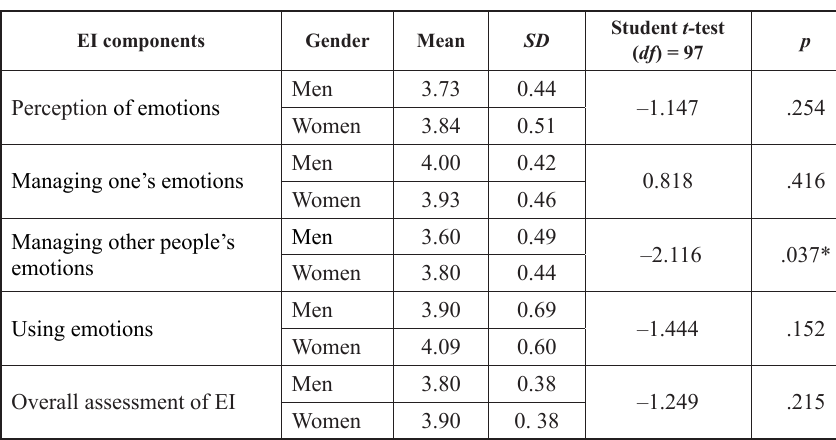
Table. Tennis players’ EI com- ponents estimates by gender (scores)